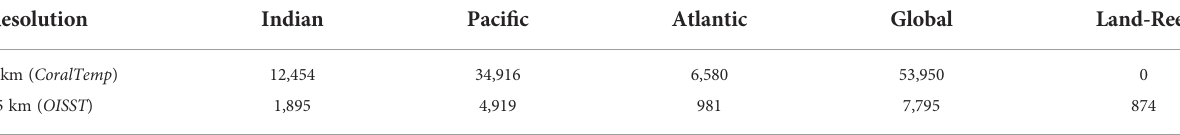
TABLE 1 Number of coral reef-containing pixels within each ocean basin boundary for the 5-km CoralTemp and 25-km OISST datasets. Resolution